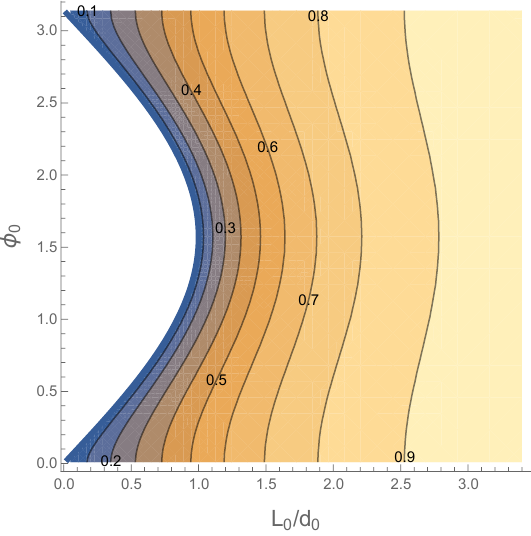
Figure 4 . Contour plot of tanh (cid:20) 0 obtained from (3.19) as a function of L 0 =d 0 and (cid:30) 0 for (cid:12)xed (cid:1) (cid:31) 0 = (cid:25) . The white region with L 0 =d 0 (cid:20) sin (cid:30) 0 is prohibited because the anti-parallel lines (2.2) 4 live in the same subspace x 3 > 0 with respect to the defect. Contour lines move to the right of the (cid:2) (cid:3) plot for increasing (cid:1) (cid:31) 0 within the interval 0 ; (cid:25) 2